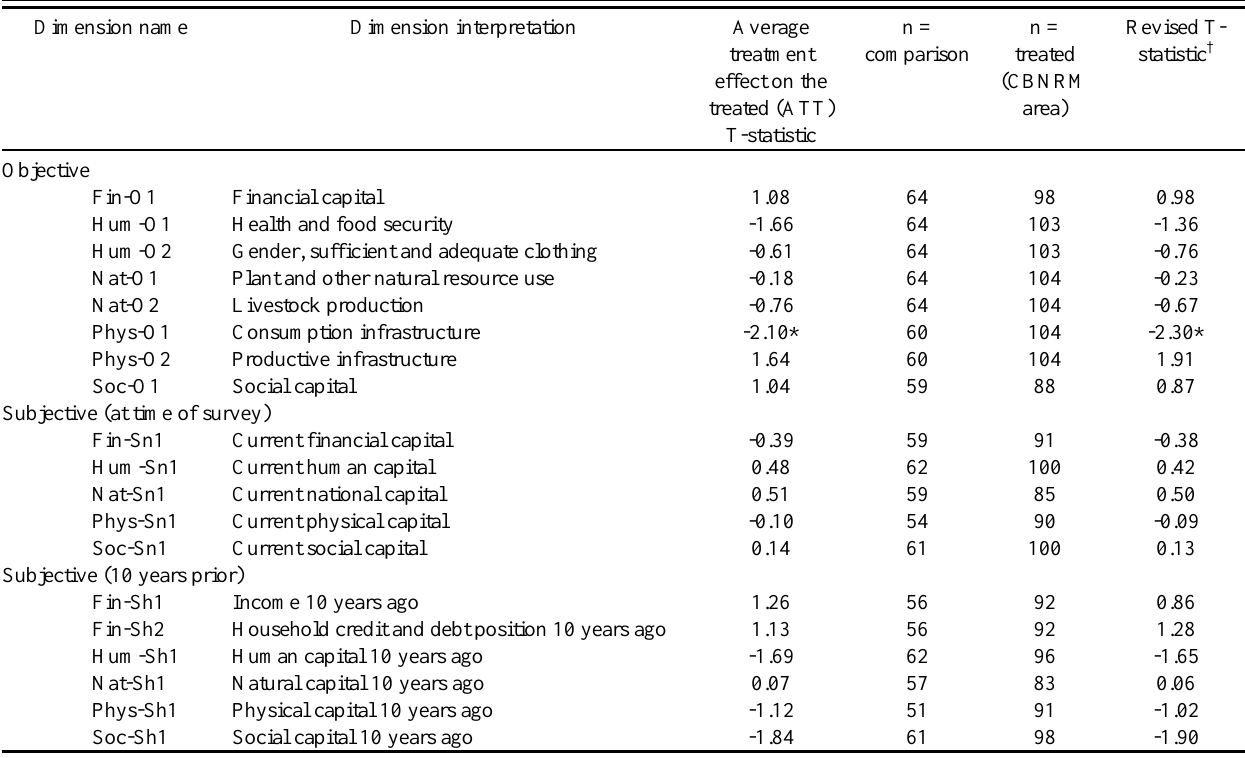
Table 4 . Kwandu Conservancy: Factor analysis-constructed poverty indices named and described, and the impacts of activities on these poverty dimensions (community based natural resource management [CBNRM] area and comparison